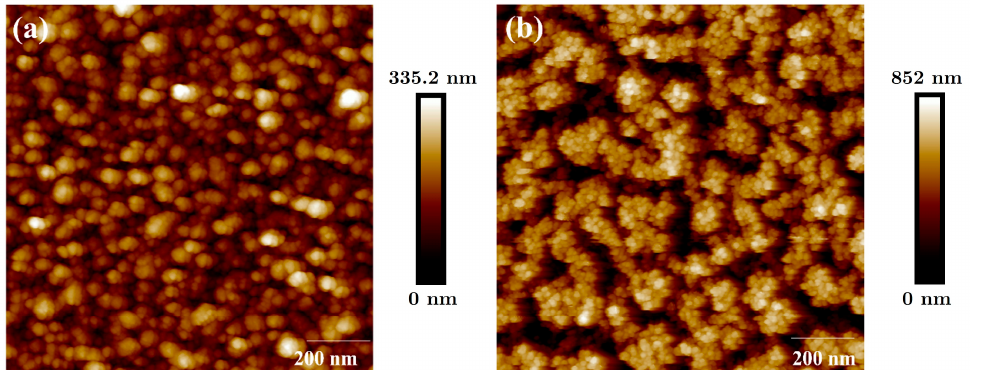
Figure 4. AFM pictures of B-Al surface layer in ( a ) and B-Au surface layer in ( b ) deposited on QCM sensors.